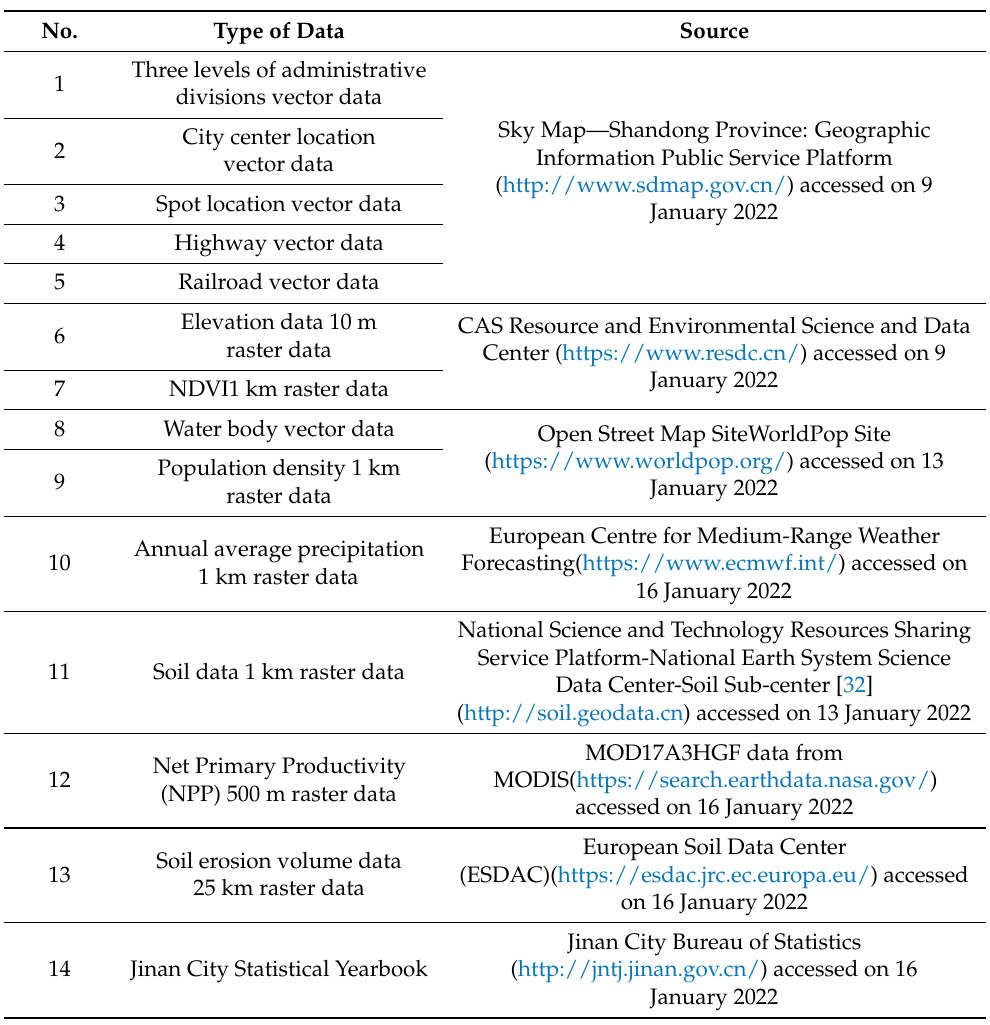
Figure 2. Land-use type. Table 1. List of data used for the study.